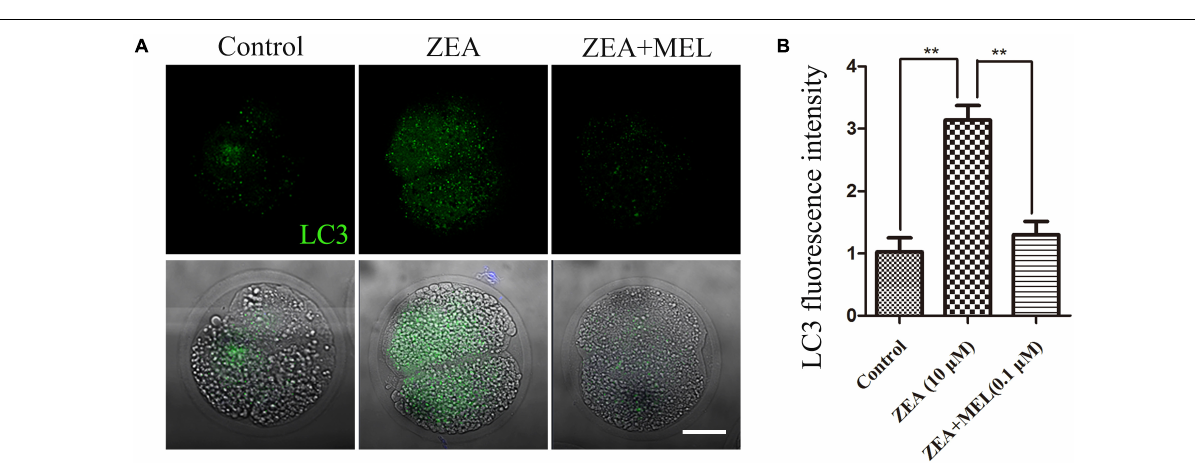
FIGURE 5 | The effect of ZEA and co-exposure of ZEA and melatonin on autophagy in ZEA exposed porcine embryos. (A) Representative images of LC3 (green) in the embryos from control, ZEA-exposed, and ZEA+MEL groups. Bar = 20 µ m. (B) LC3 fluorescence intensity in control, ZEA-exposed, and ZEA+MEL groups, and fluorescence images were measured by confocal microscope with the same settings and parameters. ∗∗ P <